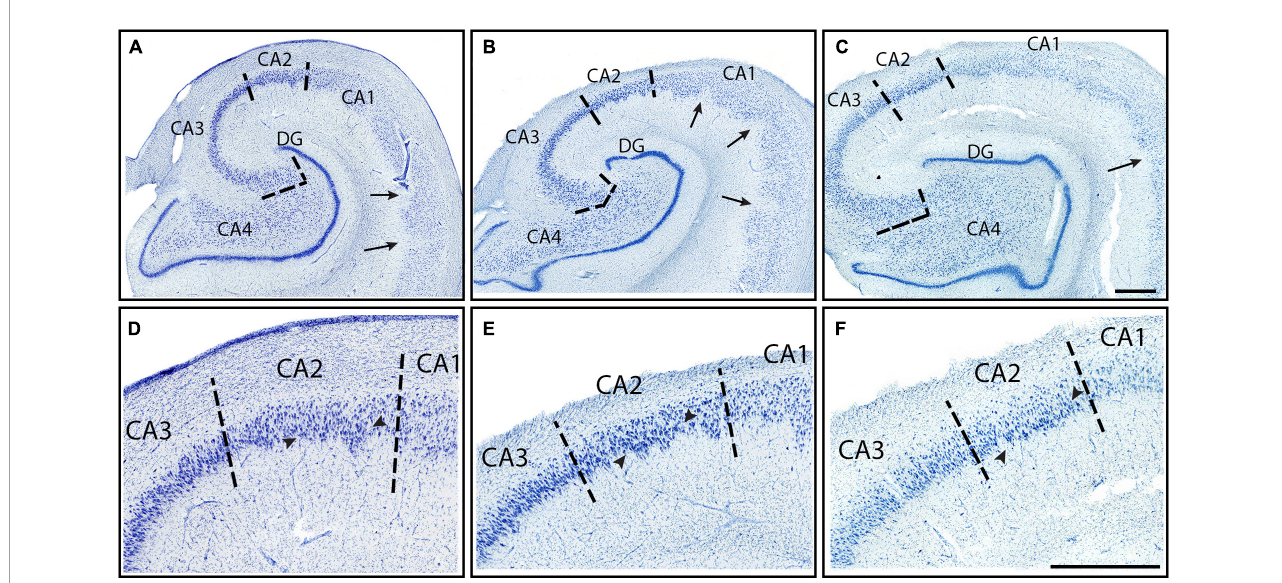
FIGURE3 CA fields (CA1–CA3) from three different cases (Cases 12, 21, and 13, respectively) stained for Nissl substance. All slides at the level of the hippocampal body. (A–C) Macro scale photographs of three cases, and a zoomed in mesoscale image (D–F) showing CA1, CA2, and CA3 from the same Nissl stained section. Arrows point to the characteristic jaggedness found in CA1’s pyramidal layer. Note the change in staining intensity from CA1 and CA2, with CA1 showing lighter staining. CA1 contains smaller neurons than both CA3 and CA2, but CA2 and CA3 have similar neuron sizes and staining intensity. CA3’s neurons exhibit more collinearity than CA2. Arrowheads in panels (D–F) denote the clustering of neurons at the inferior edge of the pyramidal layer. Magnification bars, 1 mm.